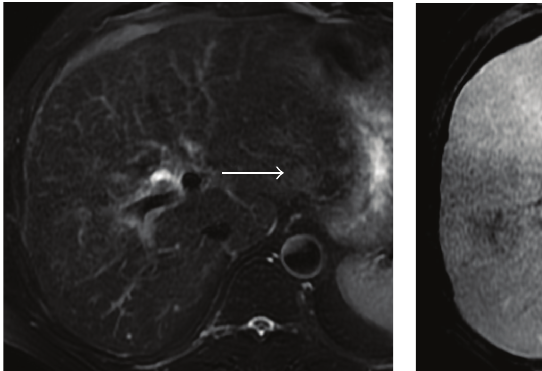
(b) Axial LAVA image in the portal venous phase shows a questionable focus of mixed intensity (arrow) in segment 3. This was mainly due to pulsation artefact from the abdominal aorta. No enhancement was seen in the corresponding section on hepatic arterial phase imaging (not shown)